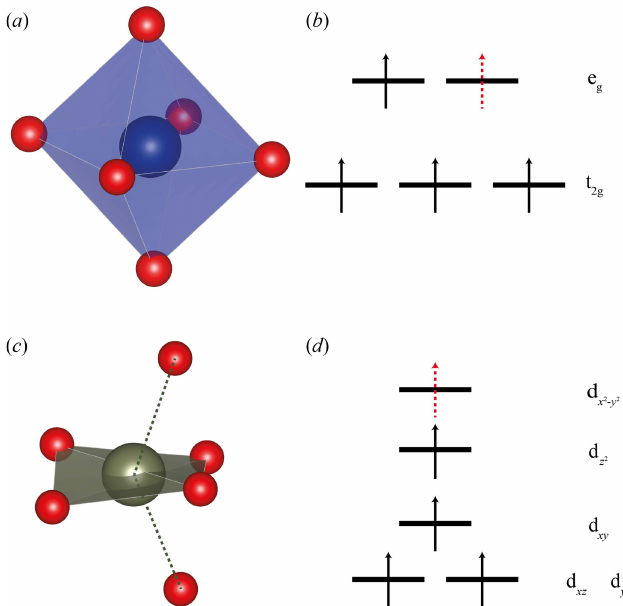
Figure 7 ( a ) and ( b ) 8 a site octahedron and the idealized, qualitative orbital diagram for Mn(III) and Fe(III). The dashed red arrow corresponds to the extra electron for Fe(III) compared with Mn(III). ( c ) Pseudo- tetragonally distorted octahedral coordination of the 24 d site; ( d ) qualitative orbital diagram for the corresponding crystal field splitting. For both orbital diagrams, energy increases in the upward